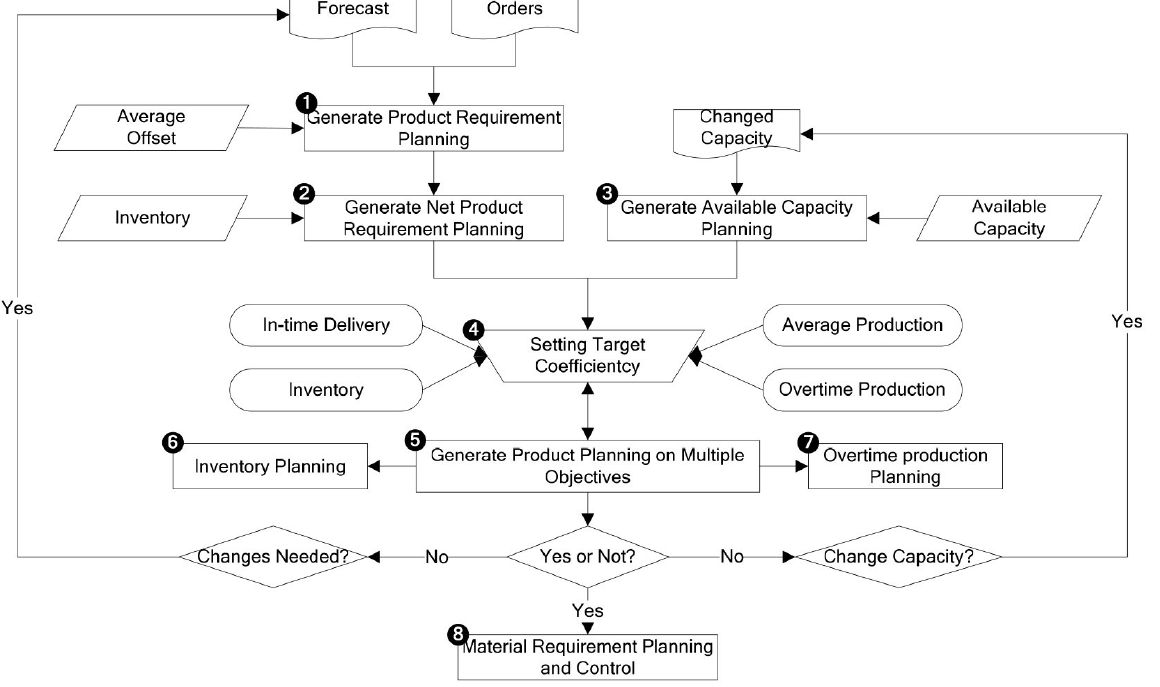
Figure 2. Production Optimization Model based on Multiple